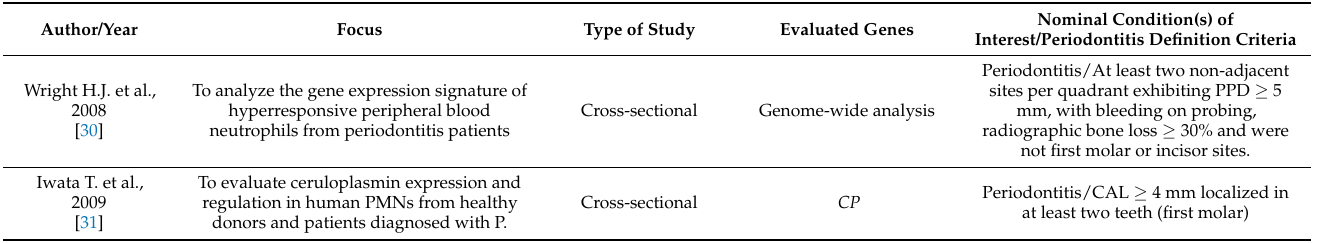
Table 3. Studies assessing polymorphonuclears (PMNs) cells or subcomponents (neutrophils) differ- ential gene expression.